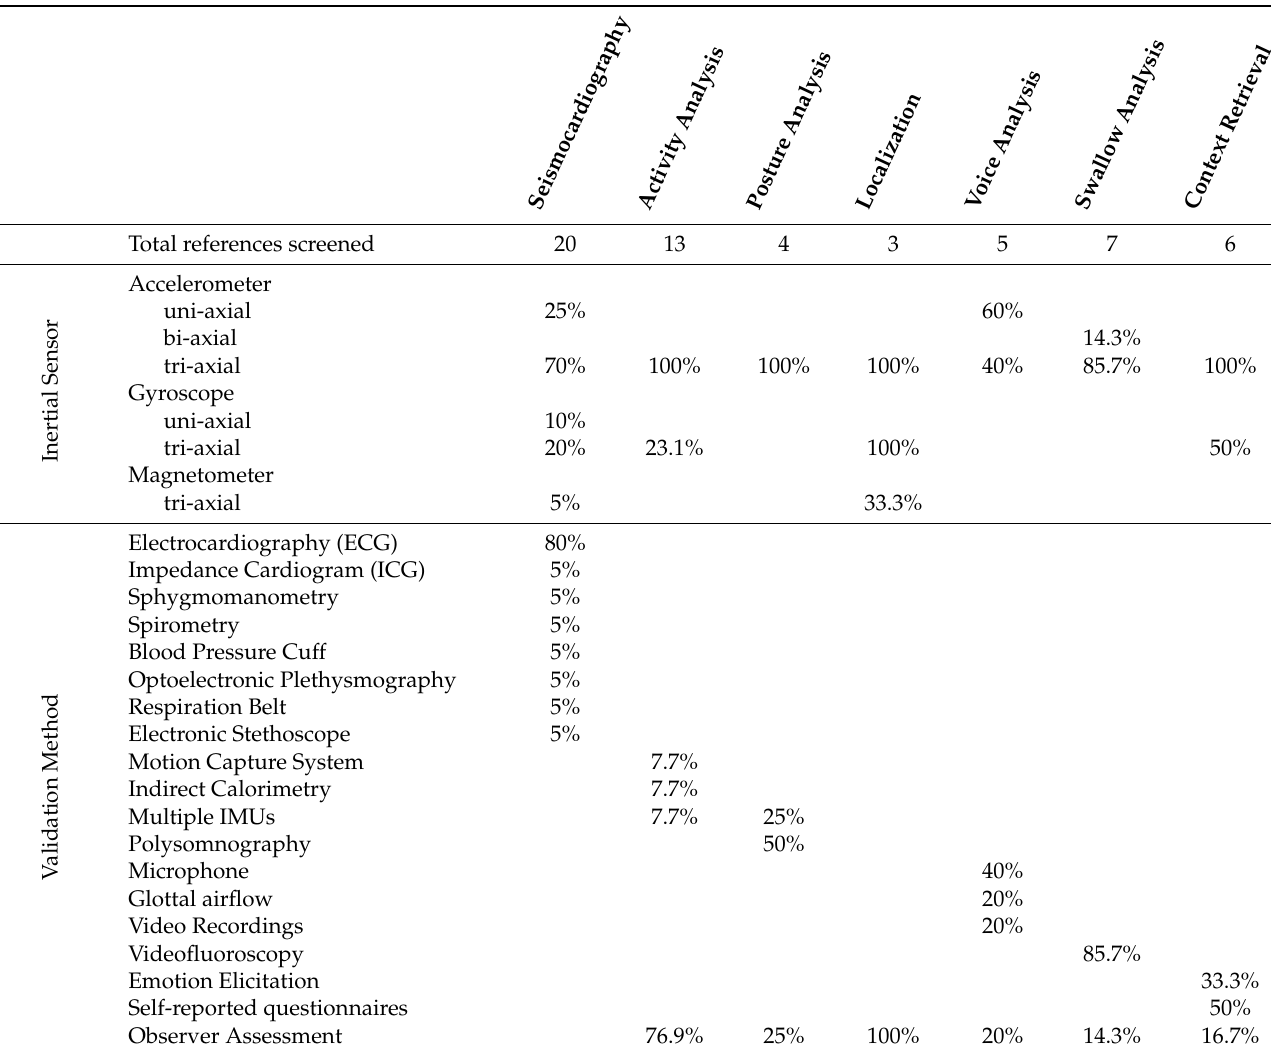
Table 4. Inertial sensors and validation methods used in the referenced studies versus their